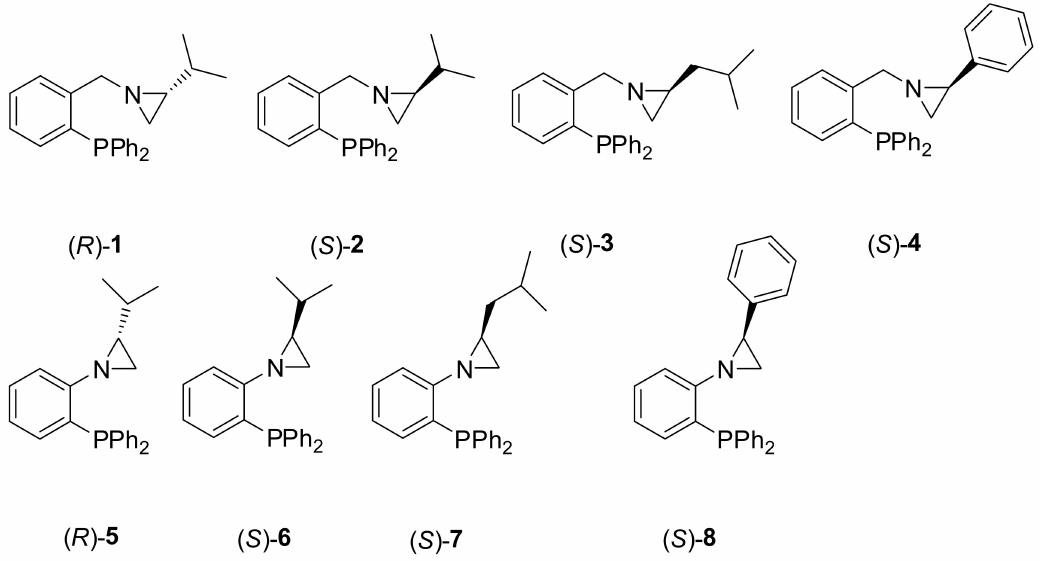
Figure 1. Optically pure chiral catalysts 1 – 8